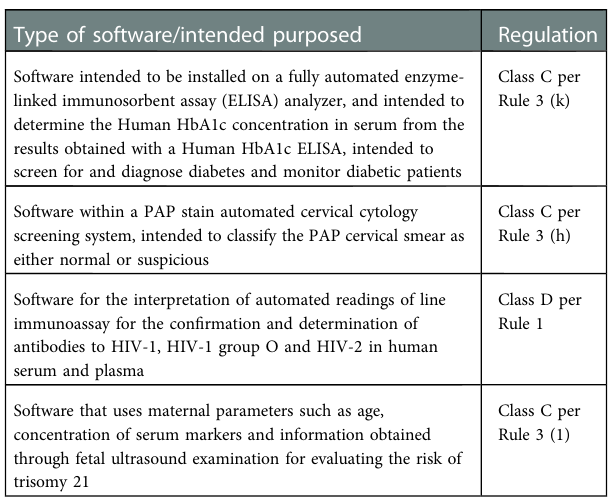
TABLE 4 MDSW classi fi cation under the